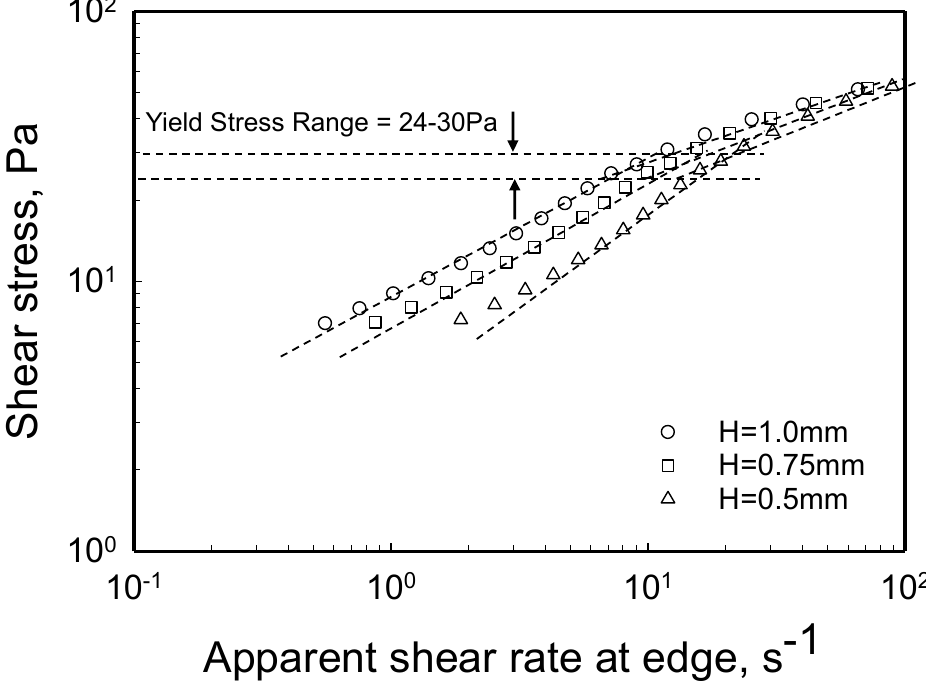
( ) . τ Figure 6. Shear stress at the edge, | τ z θ ( R ) | , versus the apparent shear rate at the edge, γ aR = Ω R / H , R θ Figure 6. Shear stress at the edge, , versus the apparent shear rate at the edge, z for three gaps, H = 1, 0.75 and 0.5 mm the yield stress range is indicated and corresponds to the / R H γ = Ω  , for three gaps, H = 1, 0.75 and 0.5 mm the yield stress range is indicated and cor- critical torque aR responds to the critical torque range.